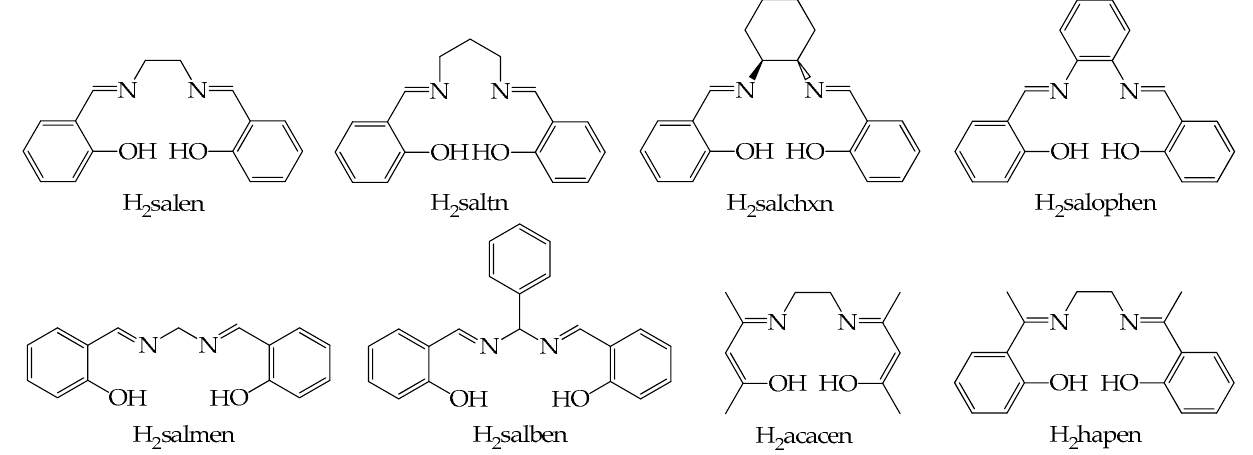
Figure 1. Molecular structures of tetradentate N 2 O 2 salen-type Schiff bases.